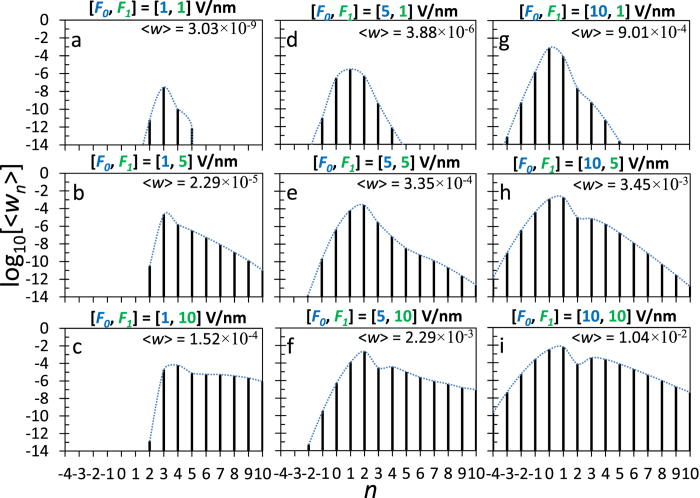
Time-averaged normalized emission current density  through the nth channel, under various combination of dc electric field F0 and laser field F1, calculated from eq. (9). The laser wavelength is 800 nm (corresponding to  = 1.55 eV). The metal is assumed to be gold, with EF = 5.53 eV and W = 5.1 eV. The dashed lines represent the envelopes of . For the laser electric field F1 = 1, 5, and 10 V/nm, the corresponding laser intensity I [W/cm2] = ε0cF12/2 = 1.33 × 1011 × (F1[V/nm])2 is 1.33 × 1011, 3.33 × 1012, and 1.33 × 1013 W/cm2, respectively.